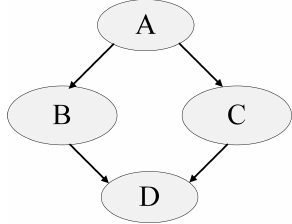
Figure 6. Diagrammatic depiction of Bayesian